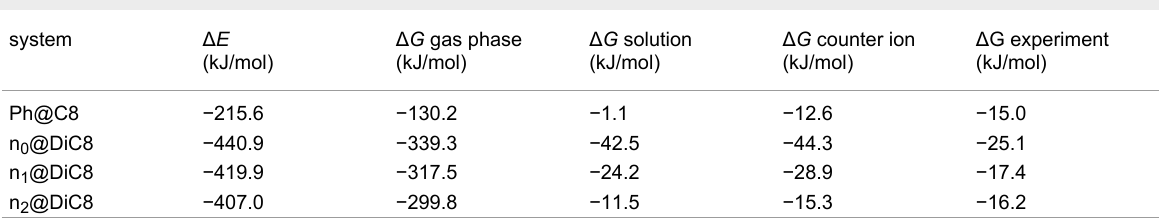
Table 3: Gibbs energy of association Δ G in solution. a